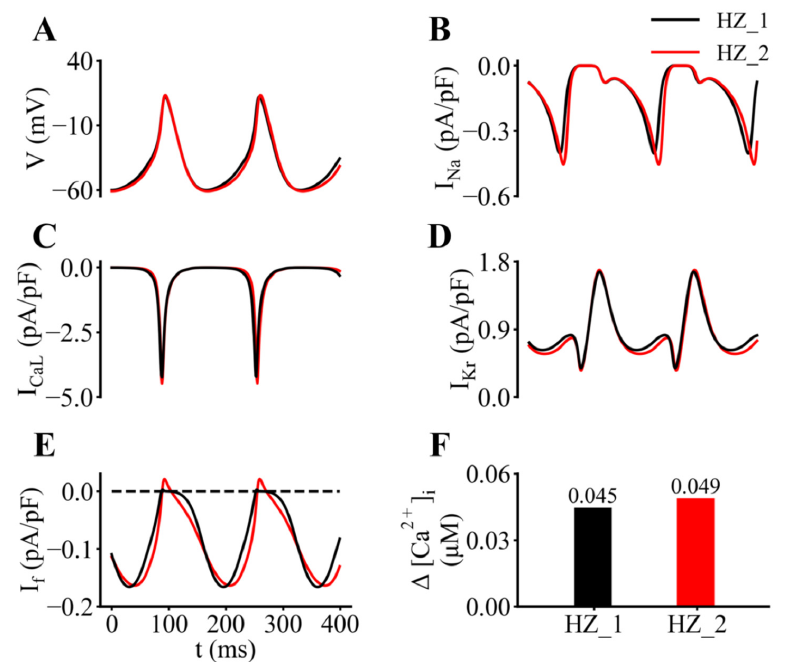
Figure 10. Mathematical simulations of SAN pacemaker activity which compare output from our original model (HZ-1) with that from the updated model (HZ-2) used in this study. In this Figure, data from the original model [8,38] is shown in black (HZ-1) and output from the updated model (HZ-2) is shown in red. ( A ): Two superimposed traces of pacemaker depolarization and action potential cycles computed from HZ-1 and HZ-2 models. ( B – E ): Corresponding data for the Na + current, I Na ; the L-type Ca 2+ current, I CaL ; the rapid delayed rectifier K + , I Kr current, and the hyperpolarization-activated cation current, I f , respectively. ( F ): Changes in intracellular Ca 2+ measured as the difference between diastolic and systolic levels.